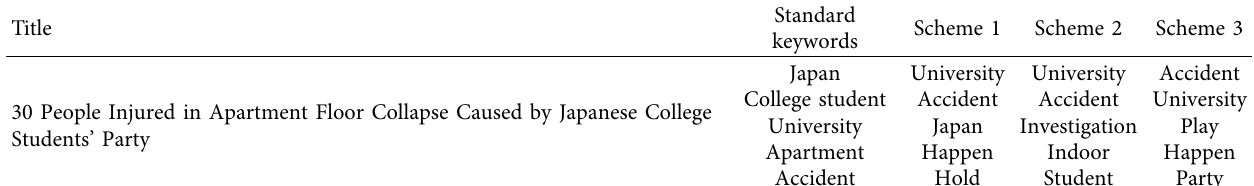
Table 3: Comparison of three parallel combination fusion experiments.